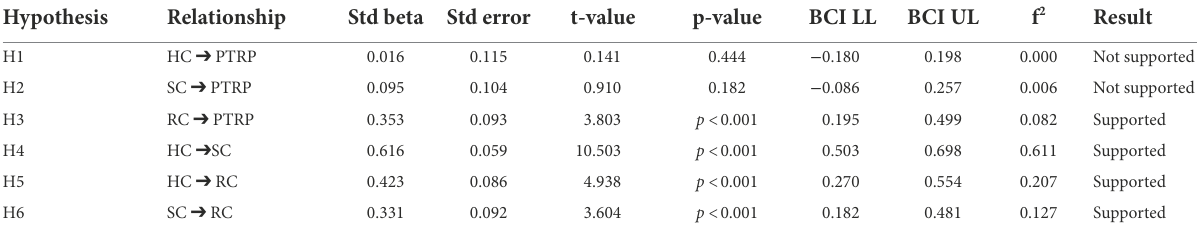
TABLE 6 Hypotheses testing direct